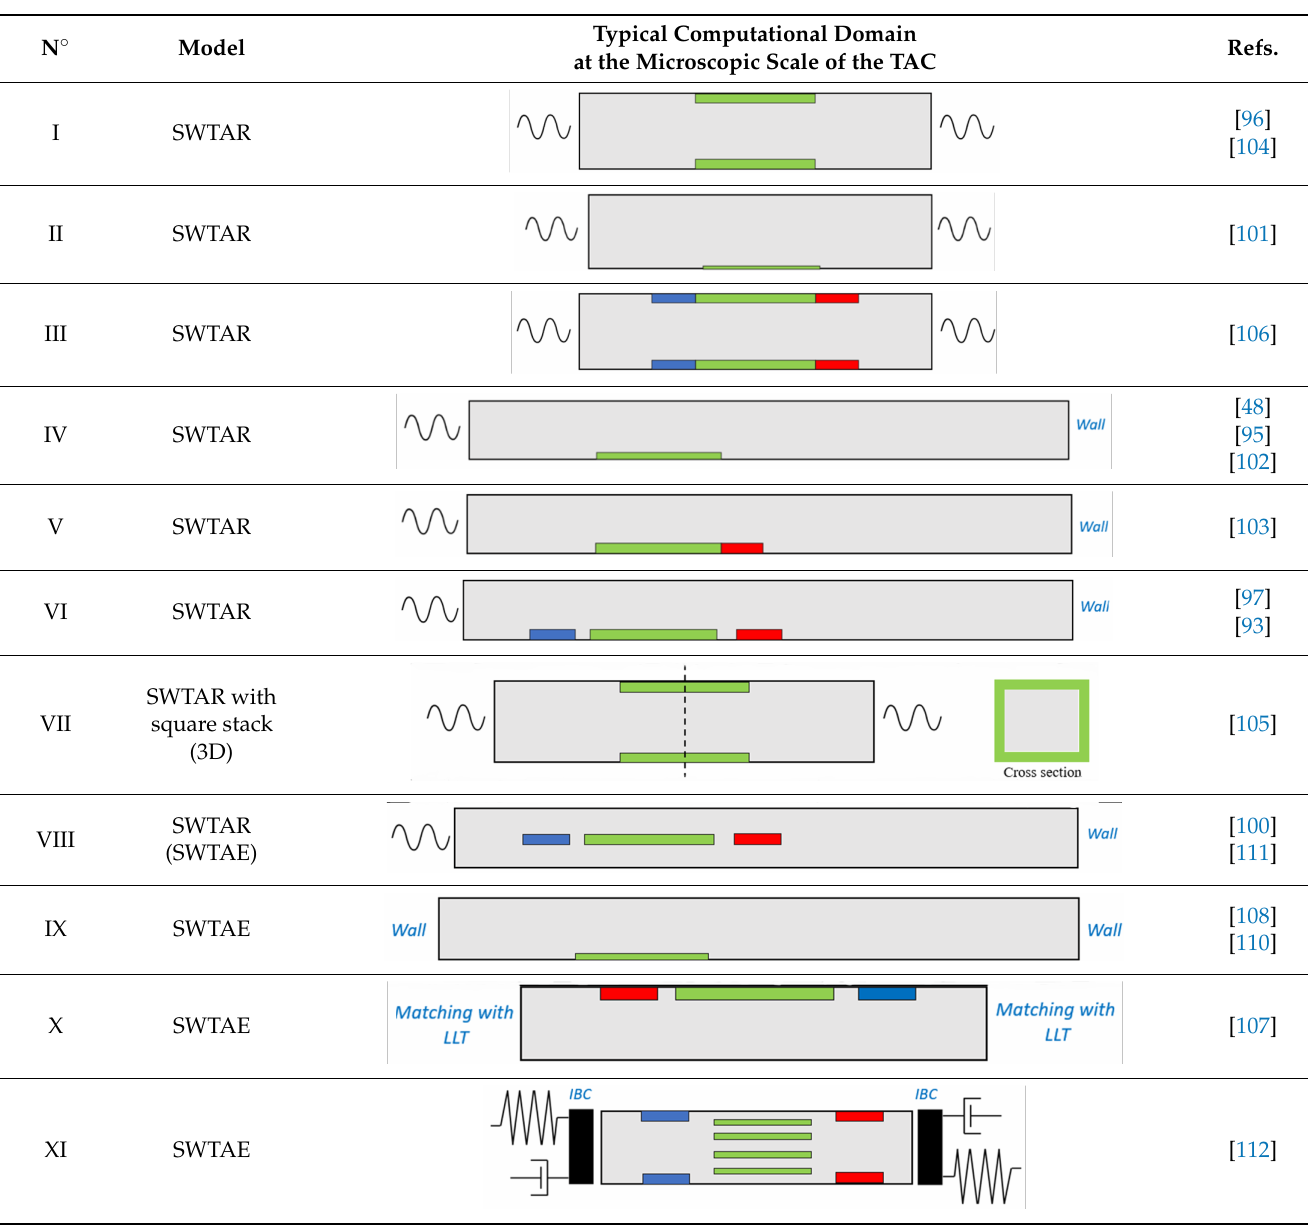
Table 1. Model and computational domain of the single TACs found in the literature (in blue, green and red are a cold HX, a stack and a hot HX, respectively); the wave symbol is the oscillating boundary condition. In the second column, it is specified if the model is 3D or 2D axisymmetric.